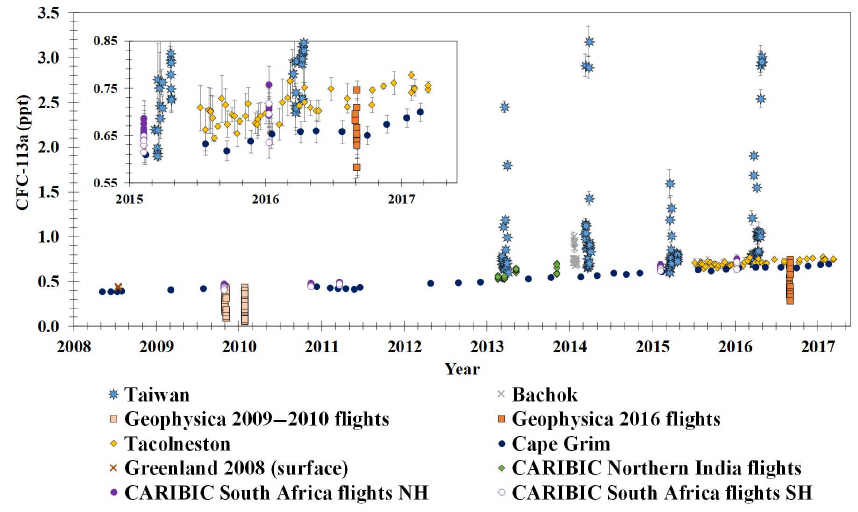
Figure 6. CFC-113a mixing ratios 2008–2017 from all the sources presented in this study with an inset of the period 2015–2017 to give an enlarged view of the Tacolneston data. The error bars represent the 1 σ standard